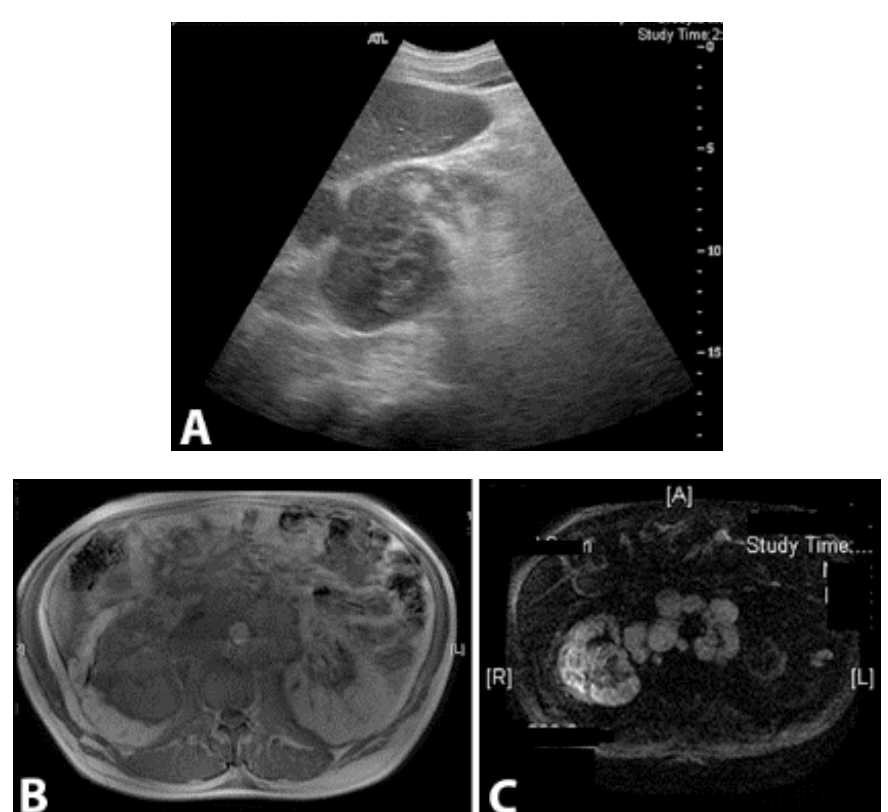
Figure 1. A, Renal ultrasound revealed multiple hypoechoic lesions in the right native kidney. Abdominal MRI showed an enlarged right native kidney with irregular margins (B). Additionally, retroperitoneal adenopathy was observed